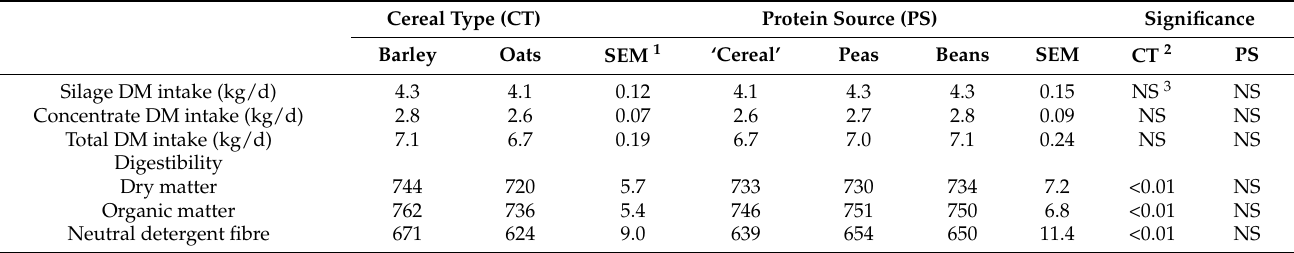
Table 7. Effects of cereal-based concentrate type and protein source on dry matter (DM) intake, apparent digestibility, nitrogen (N) balance, plasma urea and rumen pH and ammonia concentrations of steers in Experiment